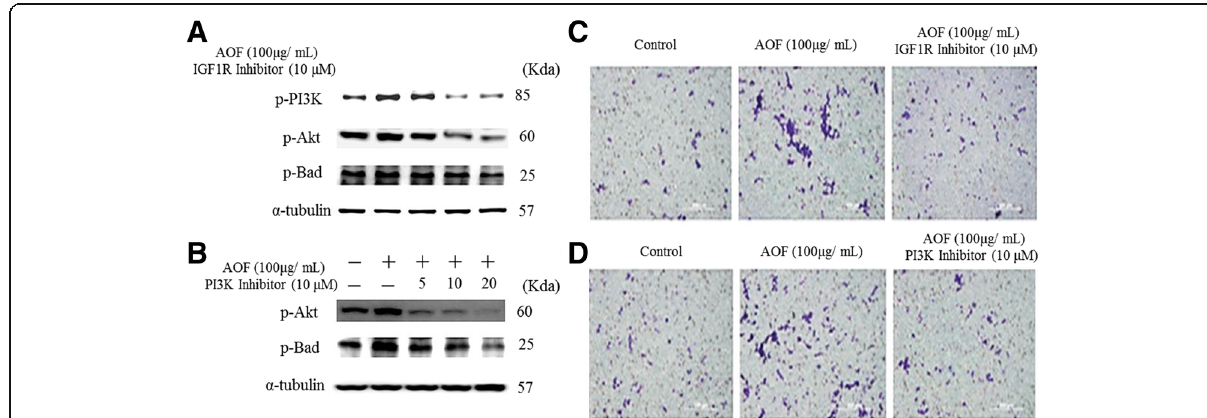
Fig. 5 AOF extract effects on Schwann cell proliferation was IGF-1signaling dependent. RSC96 cells were pretreated with IGF1R inhibitor ( a ) or PI3K inhibitor ( b ) for 1 h, and then treated with 100 μ g/ml AOF extract for 24 h. Western blot analysis showed that AOF-induced the up-regulation of p- PI3K, p-Akt and p-Bad which was markedly suppressed when treated with either AG1024 (IGF1R inhibitor; Promega, Madison, WI, USA) or LY294002 (PI3K inhibitor; Promega, Madison, WI, USA) inhibitor. α -tubulin was used as a load control. After incubation with AOF extract, migration assay was performed using Boyden chambers treated with IGF1R inhibitor and PI3K inhibitor, respectively ( c and d ). The number of migrated cells was much more in the cells treated with AOF extract, but the migration effect was blocked when treated with IGF1R inhibitor and PI3K